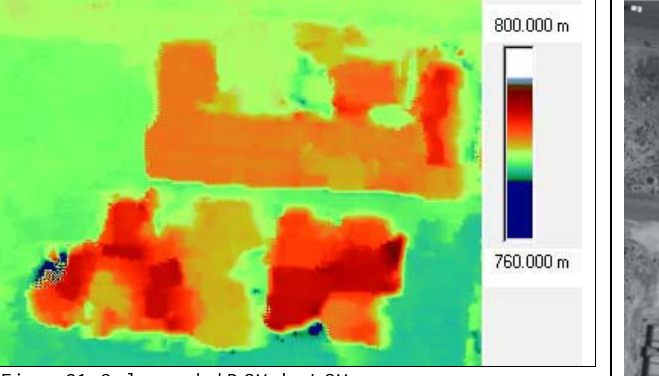
Figure 21: Colour coded DSM by LSM, IKONOS stereo model 1m GSD